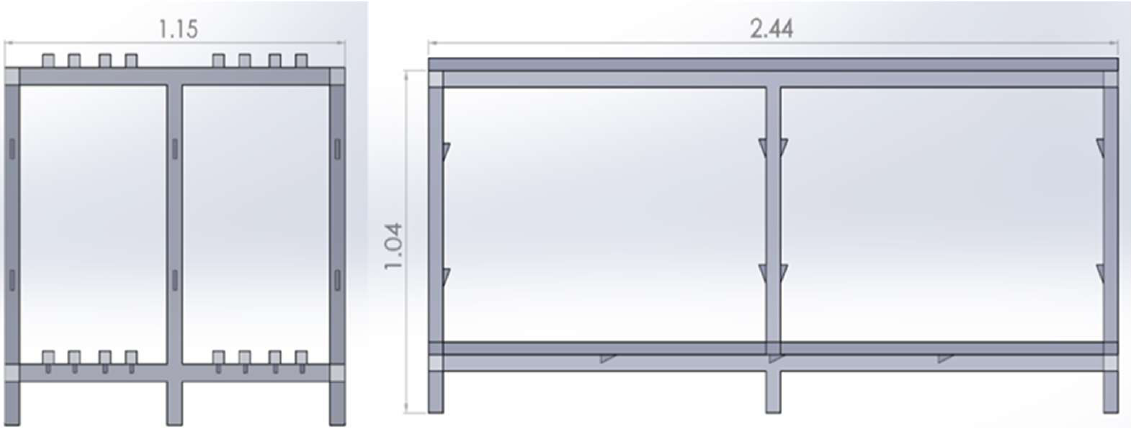
Figure 3. Vent plate attached to the bottom the rack. All perforations are circular and 3 mm in di- ameter. Dimensions are in meters.